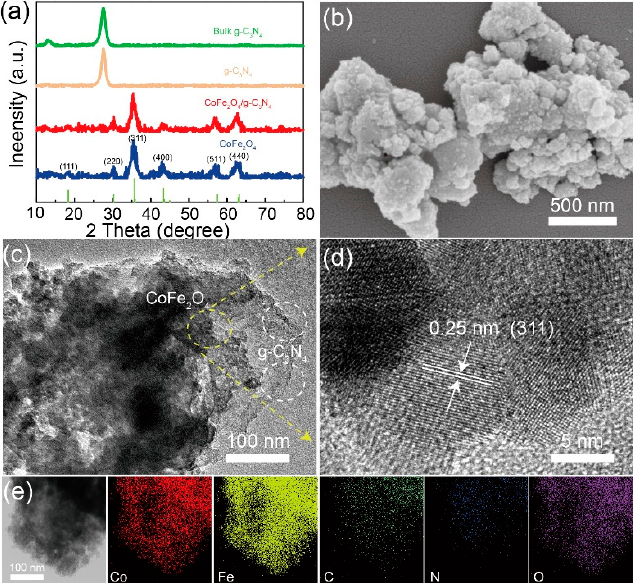
2 O 4 /g-C 3 N 4 composite.